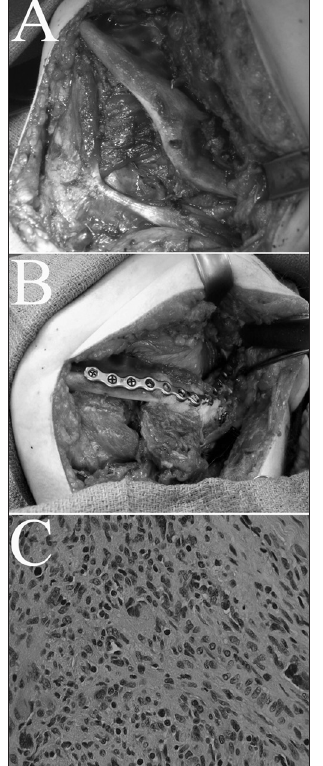
Figure 1. (A) Intraoperative photograph before resection, de- monstrating erosion of the angle of the mandible by the tumor. (B) The osteotomized fibula bone is inset within the mandibular defect, and anchored to a titanium plate. (C) Microphotograph of the excised myofibrosarcoma. The typical morphology of the myofibroblasts comprises an elongated, eosinophilic cytoplasm surrounding a denser indented nucleus, and is a combination of a smooth muscle cell and a fibroblast. (Staining: hematoxylin and eosin. Original magnification: